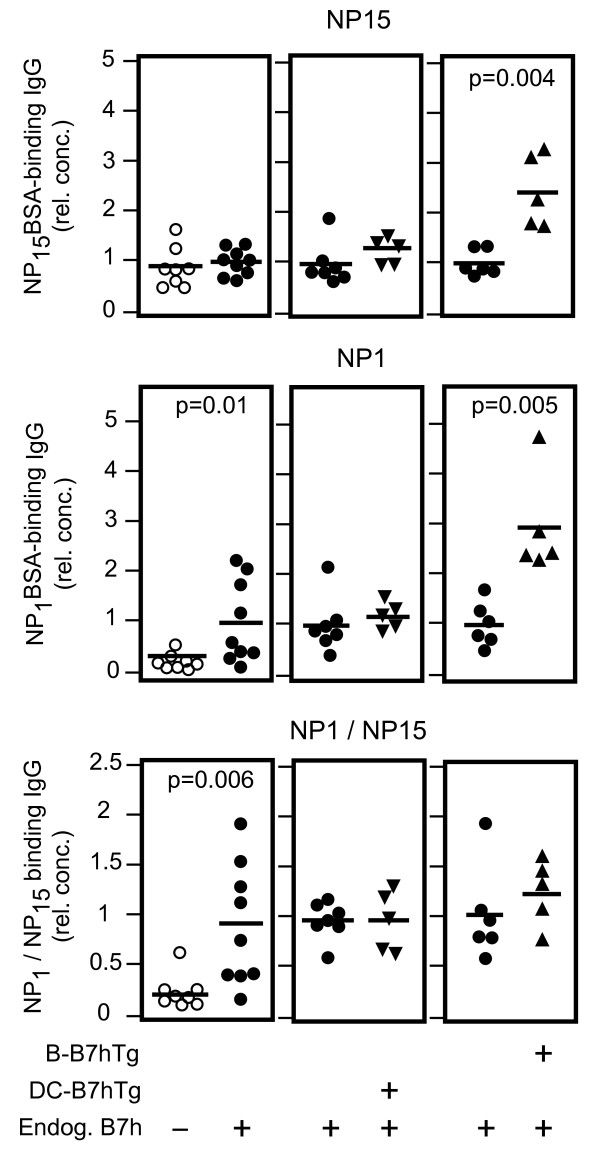
The level of B7h on plasma B cells, but not on dendritic cells, regulates high-affinity antibody responses to T cell-dependent antigens. Transgenic B-B7hTg and DC-B7hTg mice on the B7h+/+ background, and non-transgenic B7h+/+ and B7h−/− controls were immunized with NP-CGG in alum, and the affinity of serum anti-NP IgG responses were assessed by ELISA after 21 days. Total NP-specific IgG (captured with NP15BSA; upper panels), high-affinity anti-NP IgG (captured with NP1BSA; middle), and the ratio of high affinity/total NP-specific IgG (lower panels) are shown relative to wild-type responses. Each symbol represents an individual mouse and bars indicate the mean of each group. The data were normalized such that the mean of the wild-type group was equal to 1. P values are shown for comparisons where differences were statistically significant. The data are representative of three independent experiments.